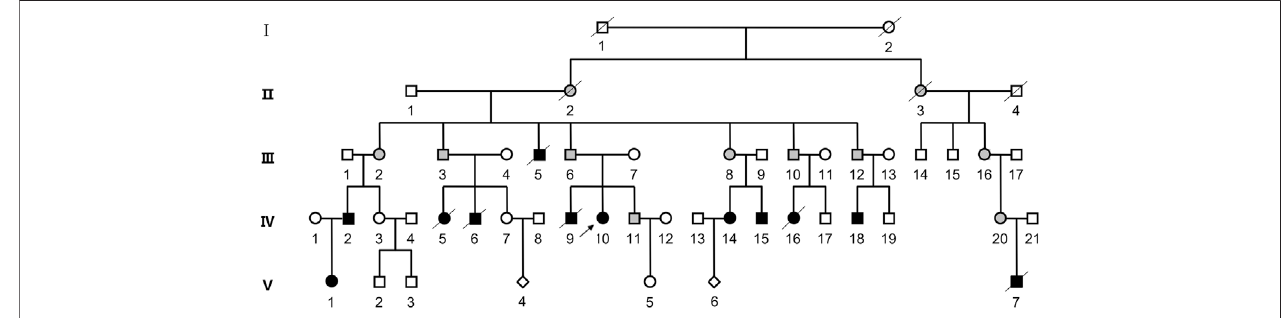
FIGURE 1 | Pedigree of the patient ’ s family. Squares represent male family members, while circles represent female family members. The diamond symbol indicates unknown gender. Slash indicates that the family member is deceased. Black symbols represent individuals with ID/DD, and blank symbols represent unaffected family members. The gray fi lled symbols indicates balanced translocation